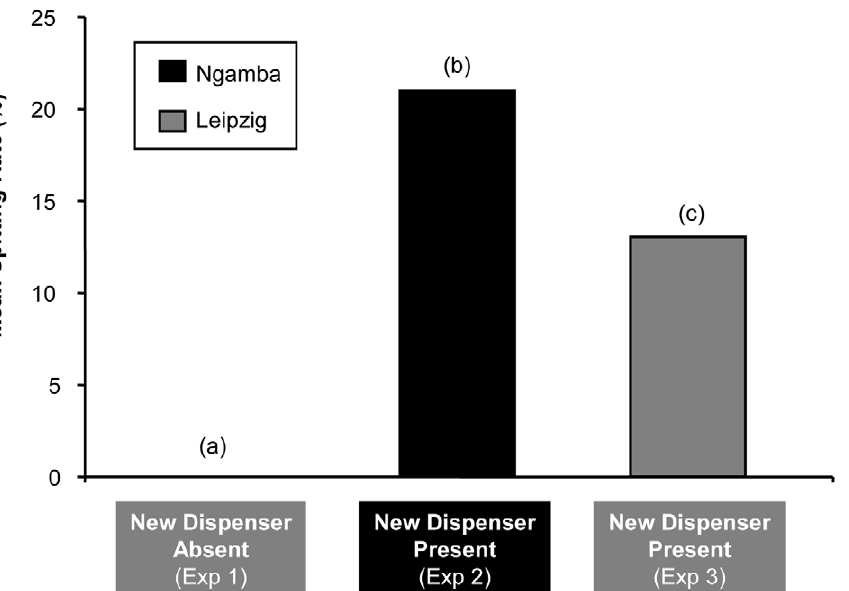
Figure 3. Mean spitting rate for each group = Sum of the individual spitting rates divided by number of subjects in each group. (a): 19 subjects from Leipzig tested with the new dispenser absent, (b): 25 subjects from Ngamba tested with the new dispenser present. (c): 16 subjects from (a) plus 3 new subjects from Leipzig tested with the new dispenser present.